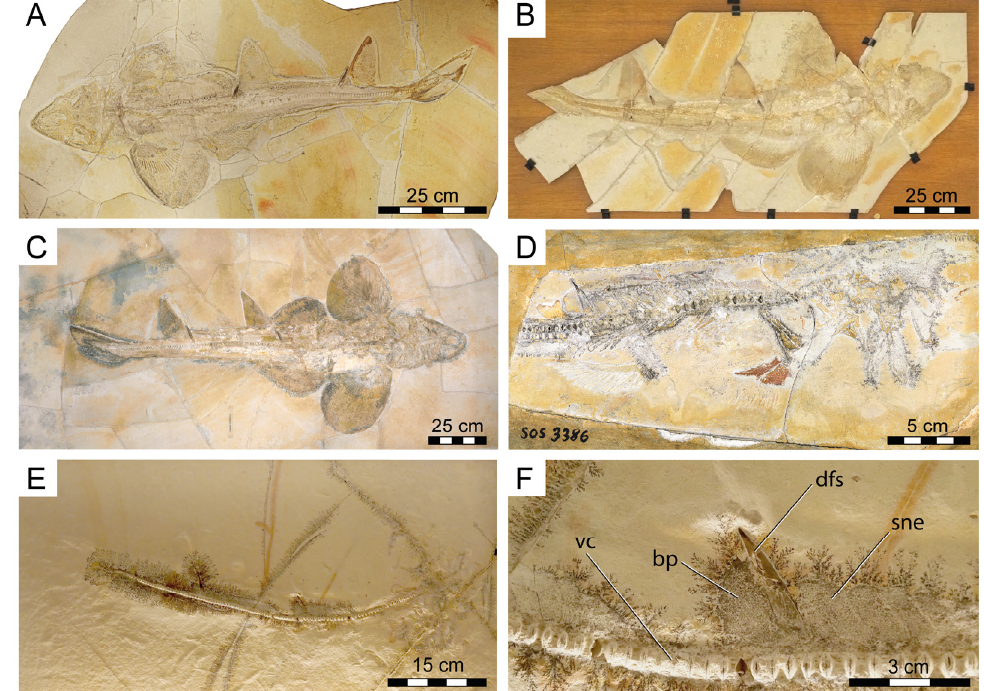
Figure 1. New fossil skeletal material of Protospinax annectans Woodward, 1918 examined in this study. ( A ) PBP-SOL-8007; ( B ) MB 14-12-22-1; ( C ) UMN uncatalogued; ( D ) JME-SOS 3386; ( E , F ) FSM 727. Abbreviations : bp , basal plate; dfs , dorsal fin spine; sne , supraneuralia; vc , vertebral column.